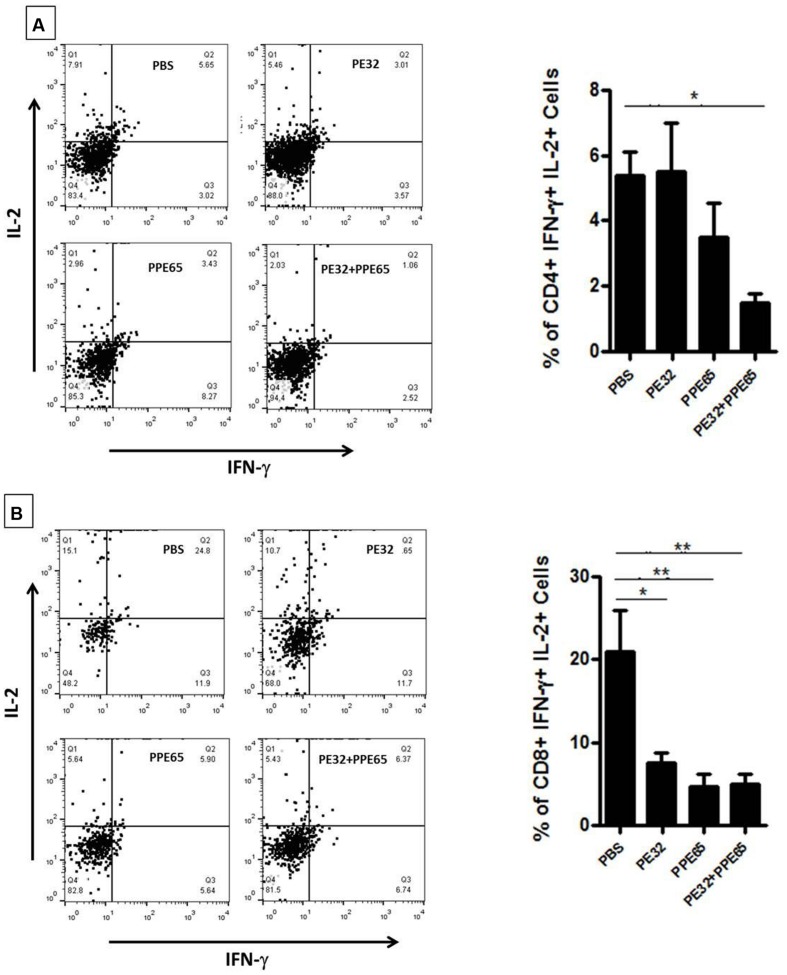
PE32 and PPE65 proteins reduce polyfunctional CD4+ and CD8+ cells in immunized mice. Splenocytes isolated from mice which were immunized with PE32, PPE65, and PE32 + PPE65 proteins were again challenged with same proteins in culture for 8 h and stained for intracellular IFN-γ and IL-2. (A) PE32 and PPE65 proteins decrease intracellular IFN-γ and IL-2 level as depicted by graphical representation of change in number of CD4+ cells positive for IFNγ and IL-2. (B) These proteins also decreased frequency of CD8+ cells expressing IFNγ and IL-2 as evident from graphical representation of change in frequency of CD8+ cells positive for IFNγ and IL-2. Dot plots are representative plots from at least four animals for each group. ∗p < 0.05, ∗∗p < 0.01.